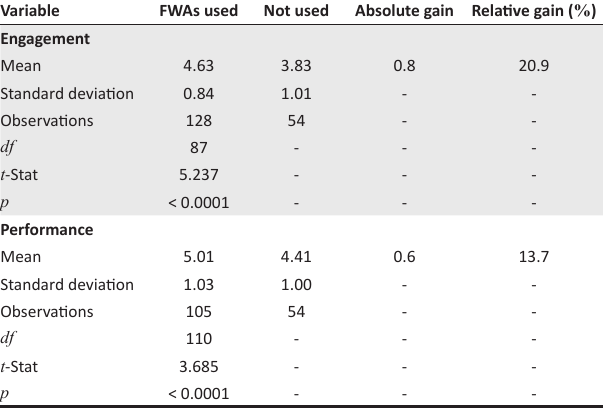
TABLE 3: Effect of flexible work arrangements on engagement and performance. Variable